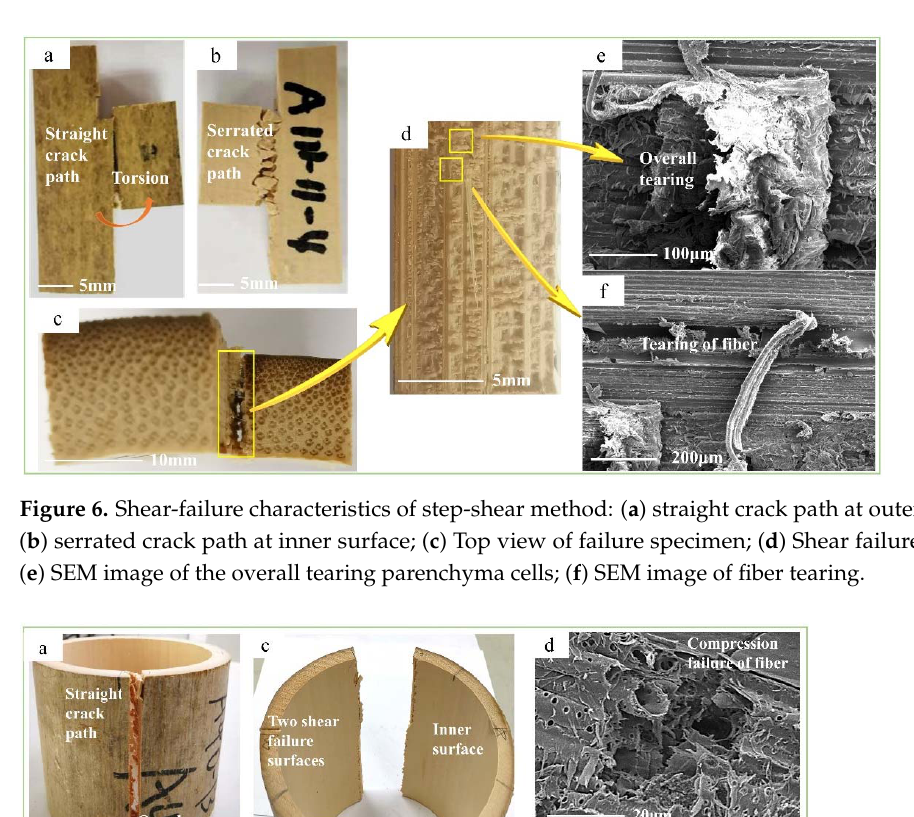
Figure 5. Shear-failure characteristics of short-beam-shear method: ( a ) the respective image of short- beam shear testing; ( b ) fracture in a zigzag manner at the bottom of specimen; ( c ) crack at outer surface; ( d ) straight crack path at inner surface; ( e ) a close-up look at zigzag crack path at specimen bottom; ( f ) SEM image of the pulled-out fiber bundle.